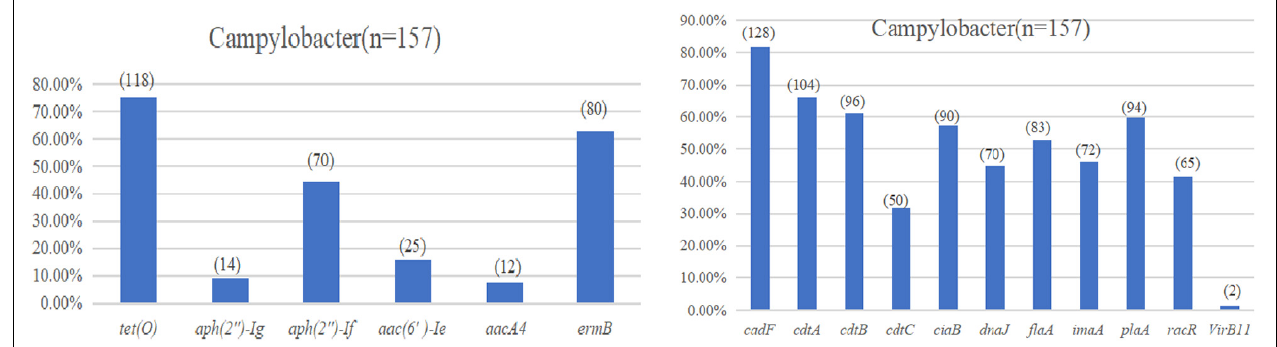
FIGURE 3 | (A) Drug resistance gene carrying rate of Campylobacter spp. (B) Virulence determinants carrying rate of Campylobacter